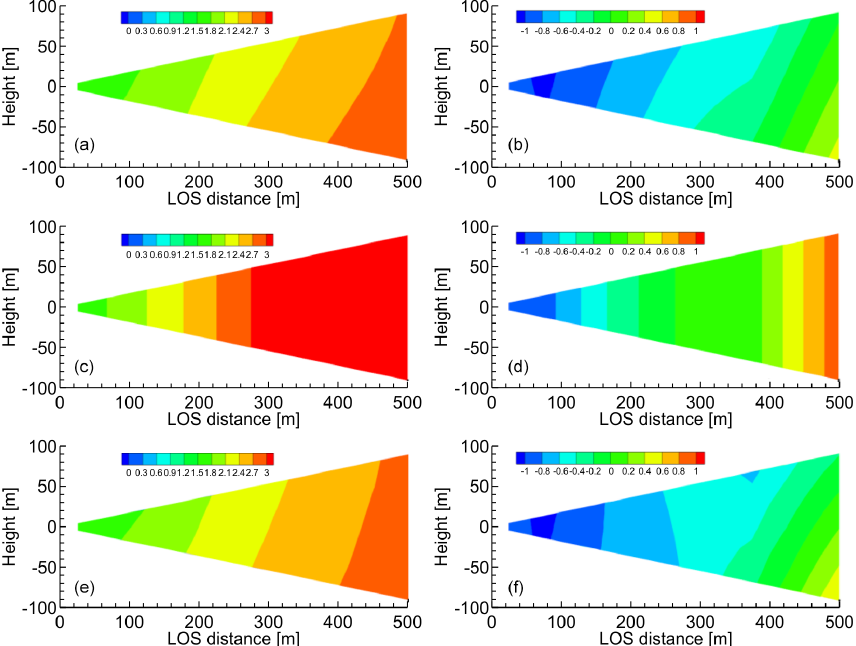
Figure 15. Distributions of horizontal and vertical wind components estimated via simple vector conversion and proposed method immedi- ately during approach to vertical wind fluctuation. (a, b) Ideal vortex model; (c, d) simple vector conversion method; (e, f) proposed method with five past LOS wind datasets. (a, c, e) Horizontal wind values; (b, d, f) vertical wind